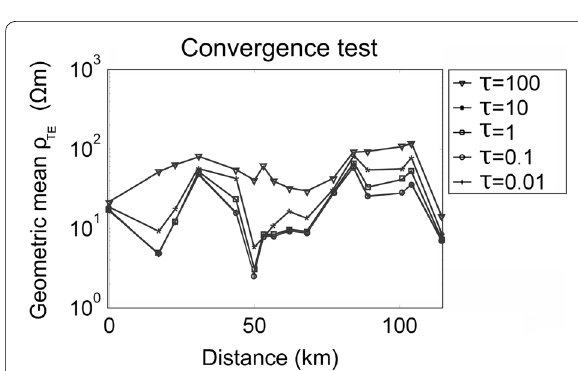
Fig. 9 The roughest models shown in this figure are chosen when the curves of the computed TE apparent resistivity converge as the regularization parameter tau decreases to zero. The graph shows how the geometric mean of the apparent resistivity curves converges for each